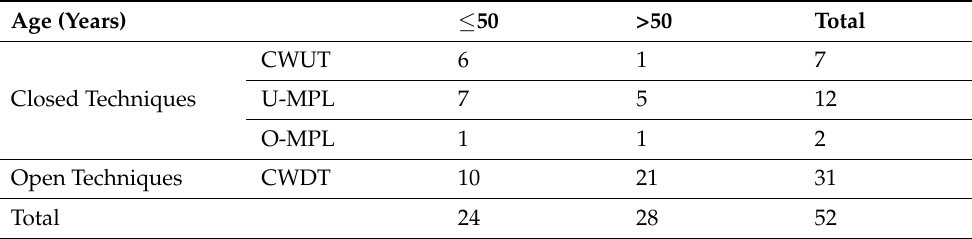
Table 1. Stratification of surgery by